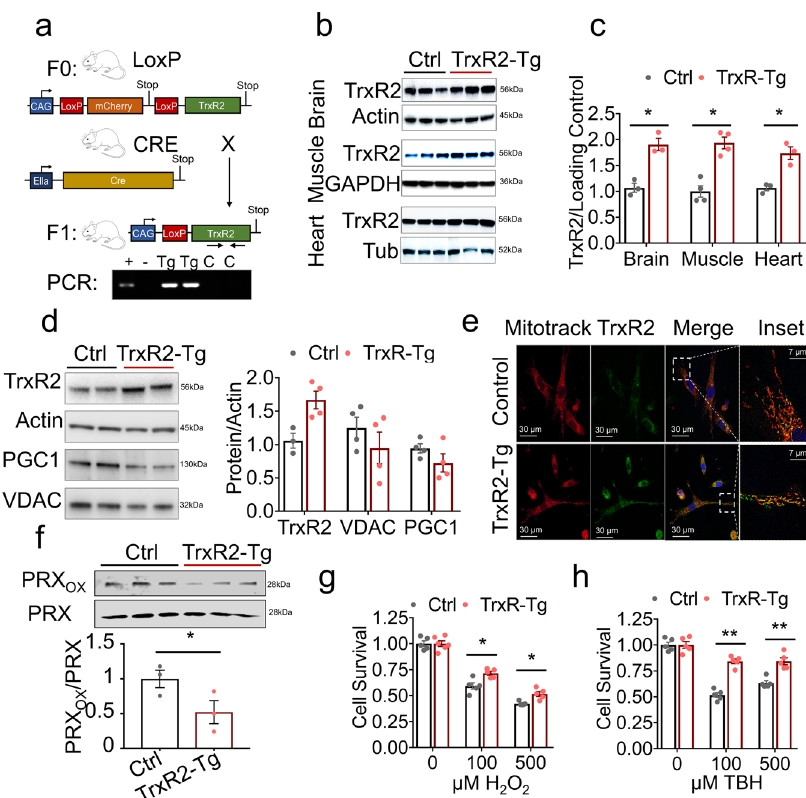
Fig. 1 Characterization of TrxR2-Tg mouse. a Breeding schematic of CAG-LoxP-STOP-LoxP-TrxR2 transgenic mice that were bred with EIIA-CRE mice producing CAG-LoxP-TrxR2 mice (referred to as TrxR2-Tg). b , c TrxR2 is elevated in TrxR2-Tg mice. Immunoblots and quanti fi cations of TrxR2 in the brain, muscle, and heart tissues from 10-month-old TrxR2-Tg mice and littermate controls ( n = 3). d TrxR2 overexpression does not alter mitochondrial abundance. Immunoblot of TrxR2, VDAC, and PGC-1 in MEFs derived from TrxR2-Tg mice ( n = 3). e TrxR2 overexpression is localized in mitochondria. Immuno fl uoresence of TrxR2-Tg and non-transgenic MEFs stained with mitotracker, representative images. f Western blot of oxidized and total levels PRX protein in TrxR2-Tg versus control liver mitochondria isolates ( n = 3). g TrxR2 overexpression increases oxidative stress resistance. H 2 O 2 cell survival assay of TrxR2-Tg and Control MEFS ( n = 3). h Tert -butyl hydroperoxide cell survival assay of TrxR2-TG MEFs and non-transgenic MEFS ( n = 3). Values are Mean± SEM. * p < 0.05, ** p <